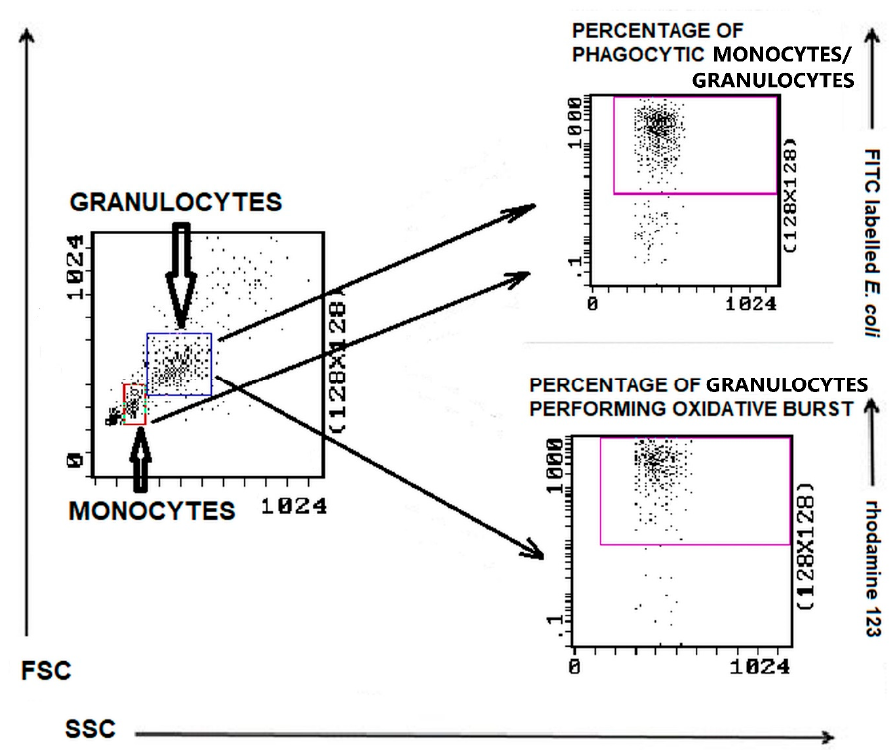
Figure 6. Gating strategy for analyzing flow cytometry data based on the granulocyte and monocyte phagocytosis and granulocyte oxidative burst assays. Granulocytes and monocytes were identified/gated in SSC scatter to FSC scatter plot. Granulocytes were analyzed for the relative number of phagocytizing cells and cells stimulated for respiratory burst (fMLP, PMA, or E. coli bacteria). Monocytes were analyzed for the relative number of phagocytizing cells.